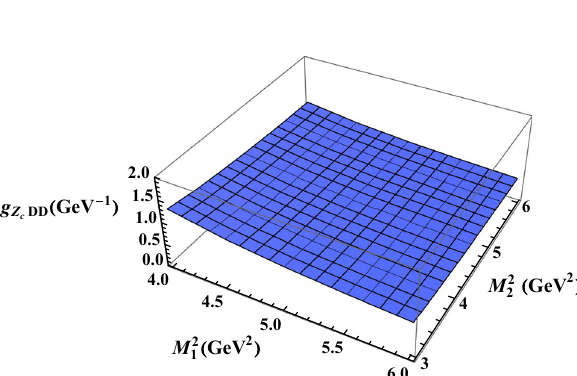
(cid:5) F ( Q 2 ) and the sum rule results for g Z Fig. 4 we plot demonstrating a very nice agreement between them.